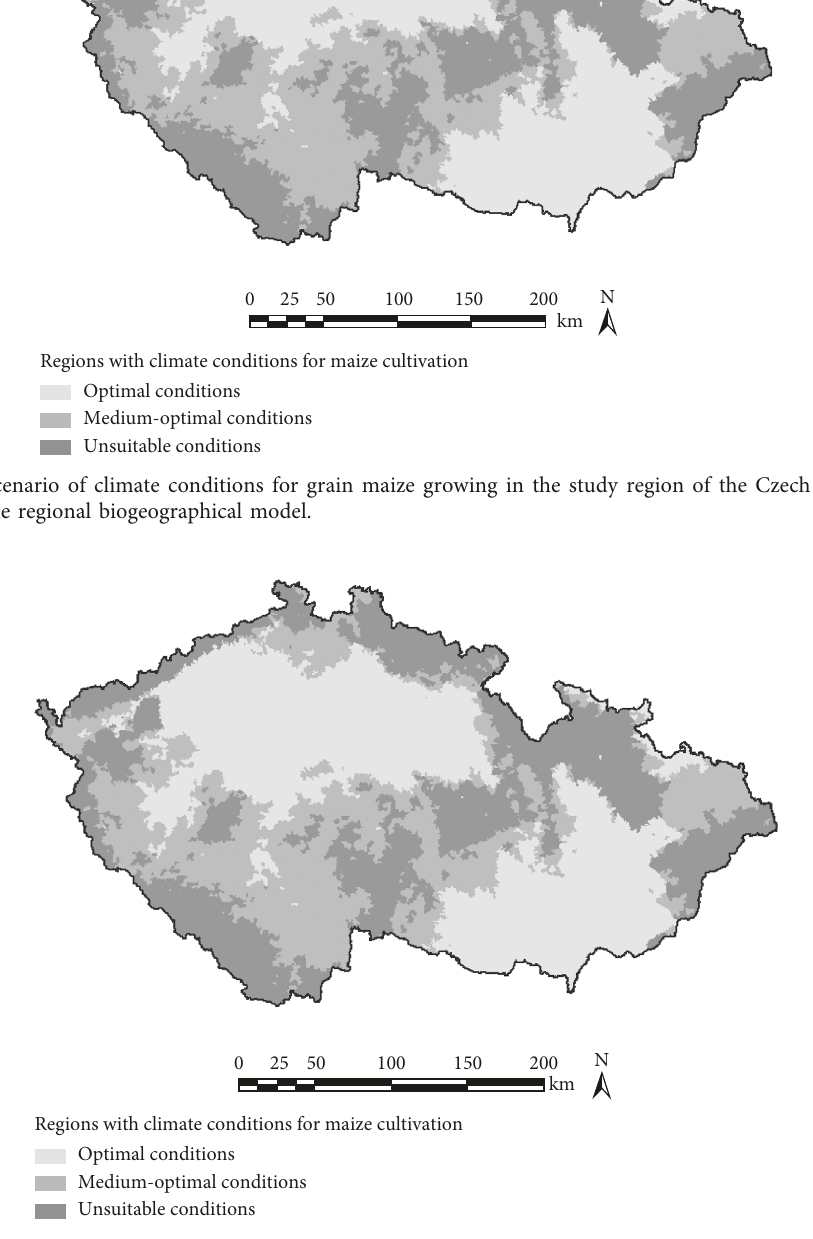
Figure 6: Prediction scenario of climate conditions for grain maize growing in the study region of the Czech Republic in the period 2071–2090, based on the regional biogeographical